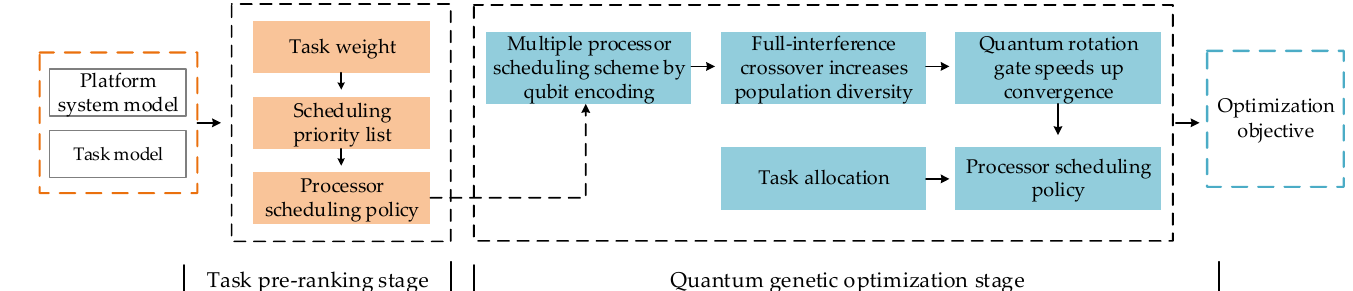
Figure 3. Diagram of classical genetic algorithm.